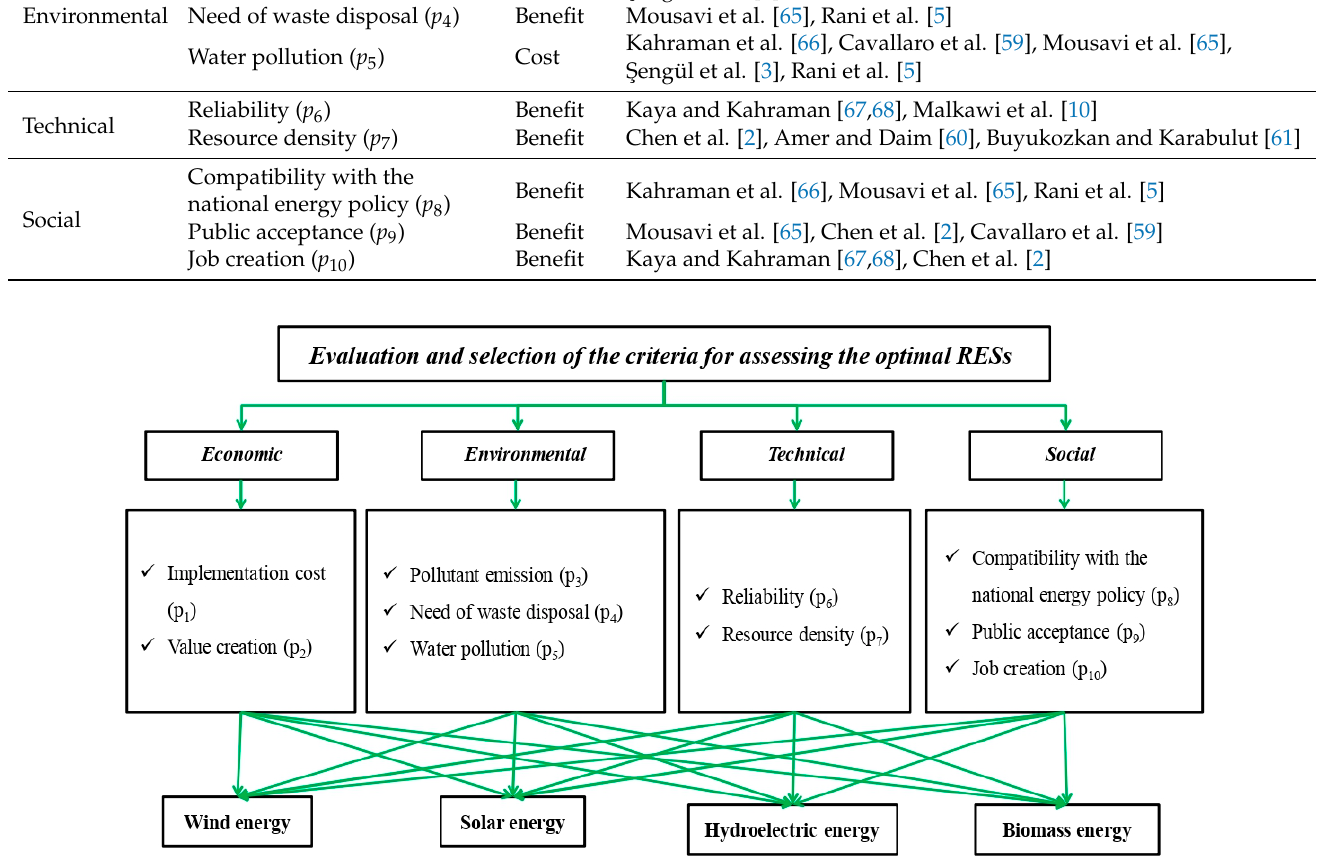
Figure 2. Hierarchical structure of selecting criteria. Table 2. Assessment criteria used in RESs selection.